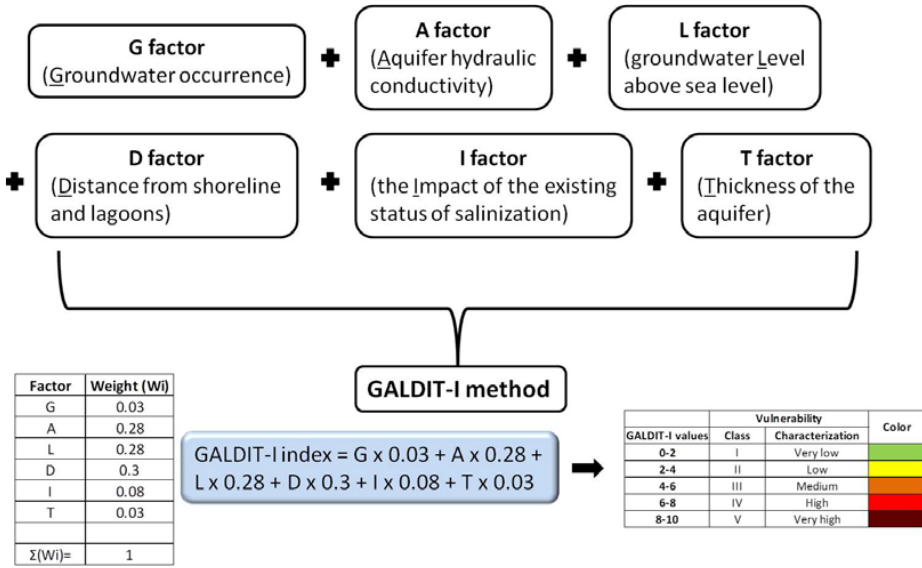
Figure 5. Diagram of the general methodological framework of the GALDIT-I.